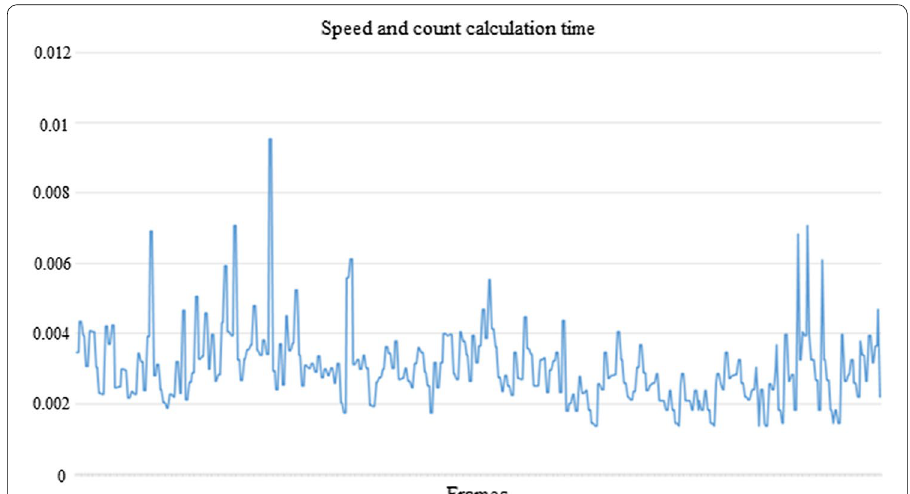
Fig. 19 The time spent for calculating the speed and number of vehicles for all the directions